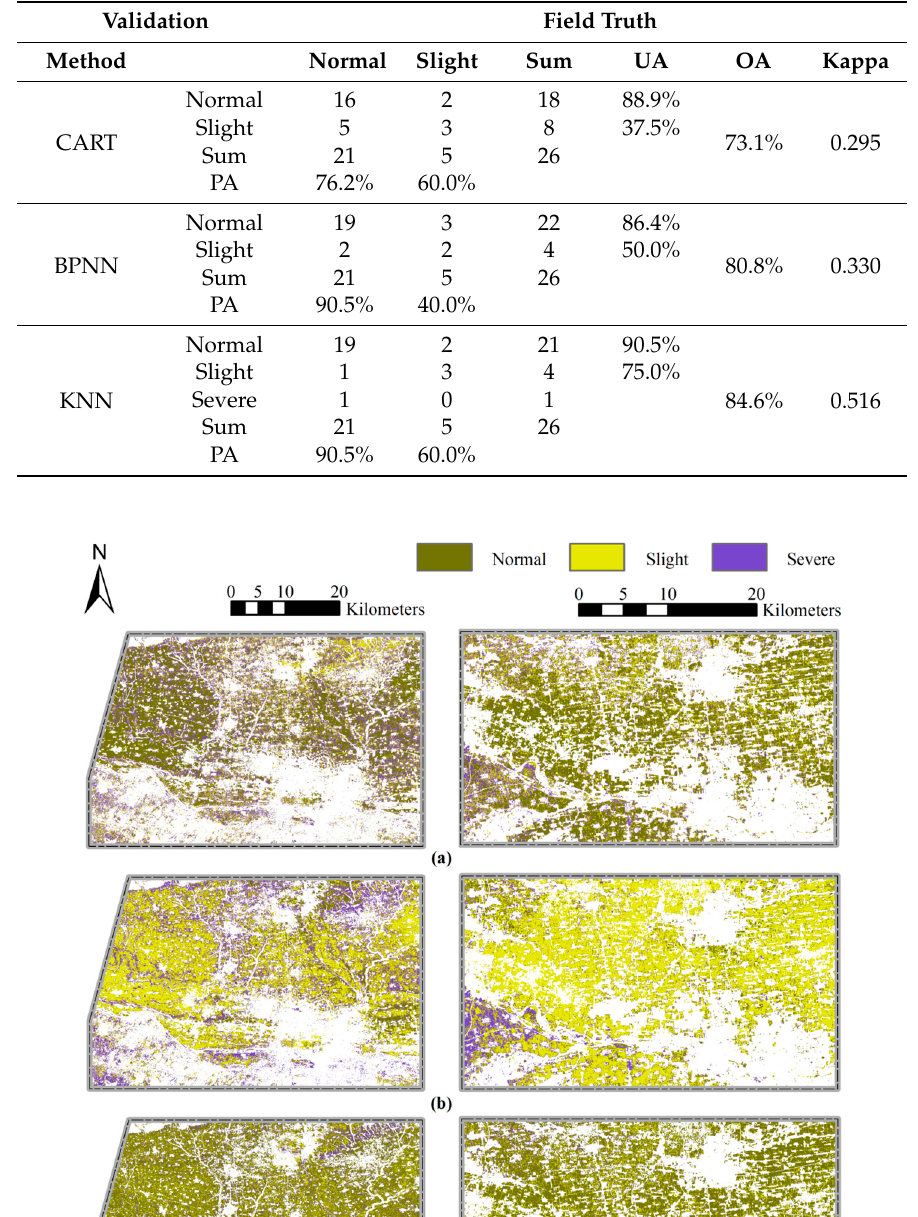
Table 6. Validation of the optimal multi-temporal VIs-based models using field truth samples in region 2.